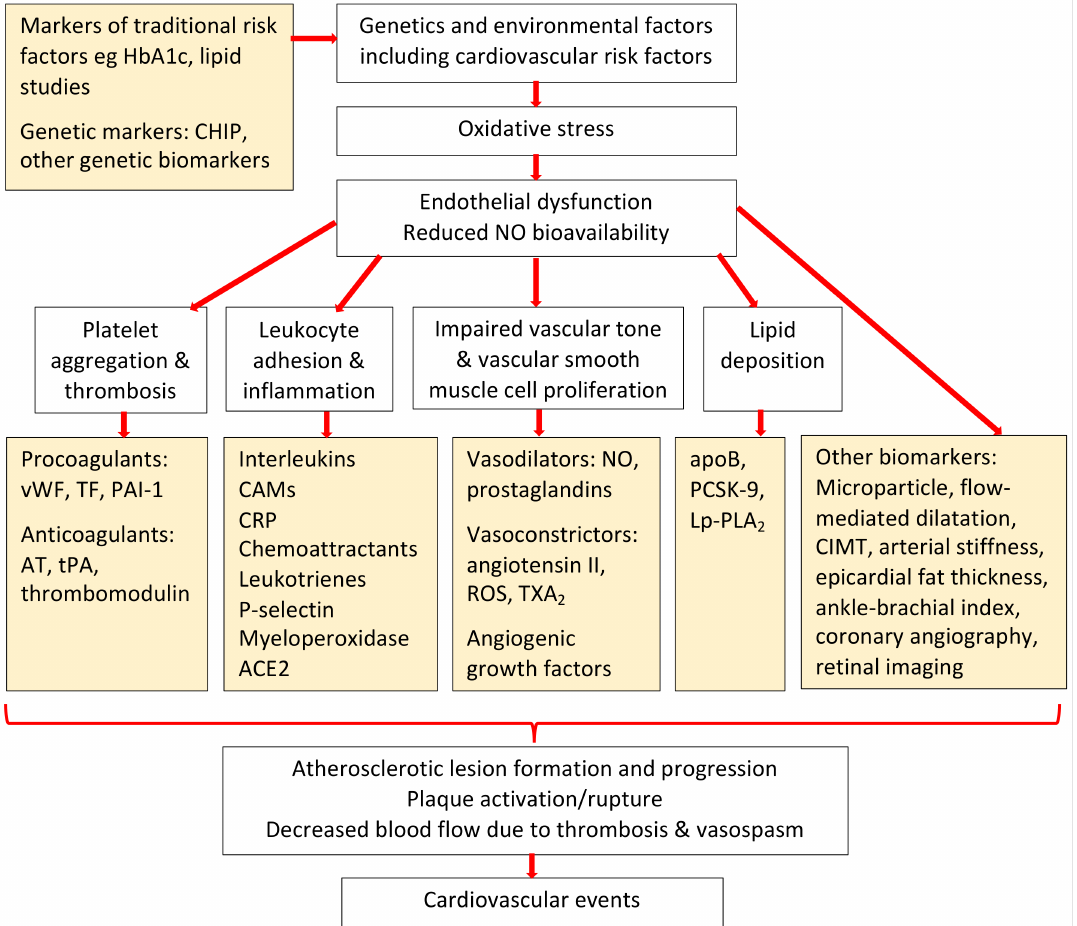
Figure 3. A simplified diagram of some of the endothelial biomarkers available to measure endothelial function (Abbreviations: HbA1c glycated hemoglobin; CHIP clonal hematopoiesis of